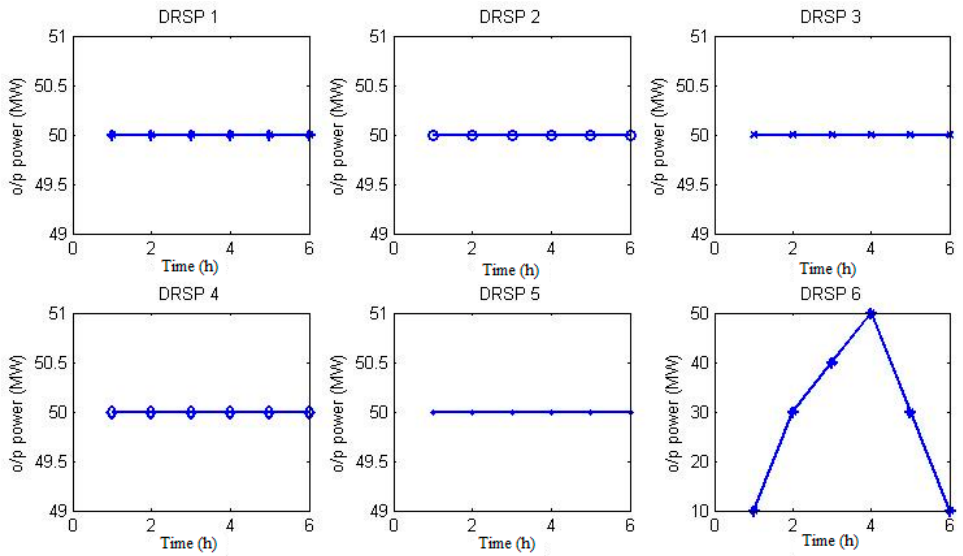
Figure 5. Unit running data for DRSP switched on during peak hours.